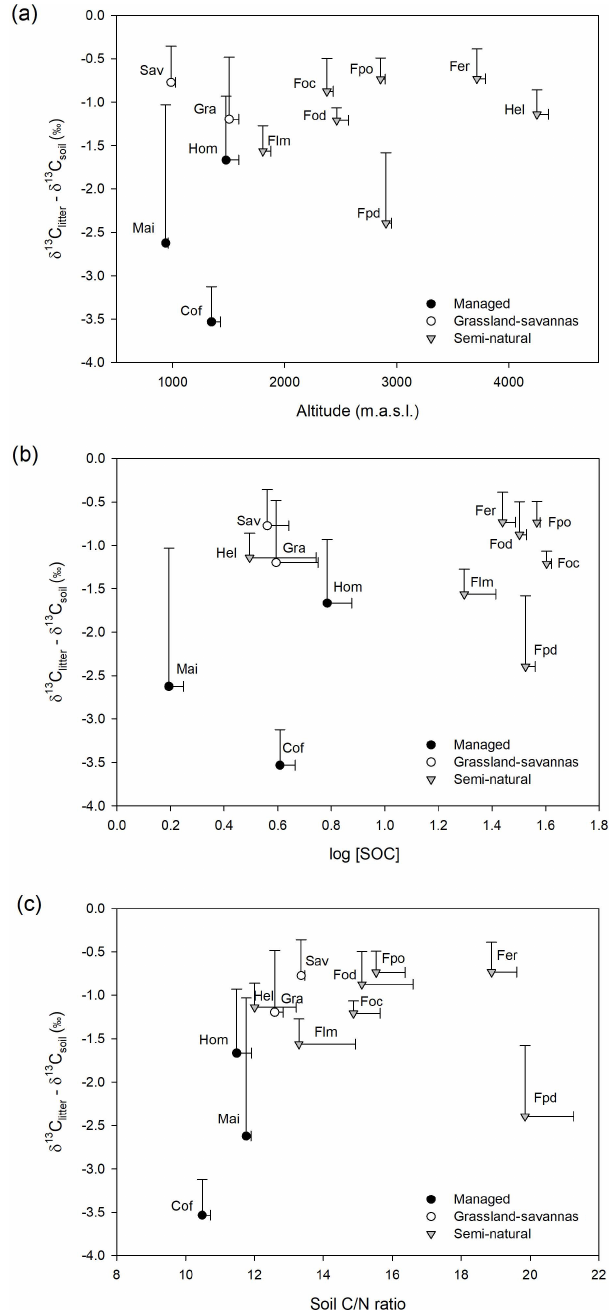
Figure 3. (a) Variation in δ 13 C-based enrichment factors ( δ 13 C itter-soil ) with elevation; (b) relationship between δ 13 C-based enrichment factors ( δ 13 C itter-soil ) and SOC concentration (log SOC); and (c) relationship between δ 13 C-based enrichment factors ( δ 13 C itter-soil ) and soil C / N ratios. Note: a savanna site with large C 3 influence was removed from the figure for